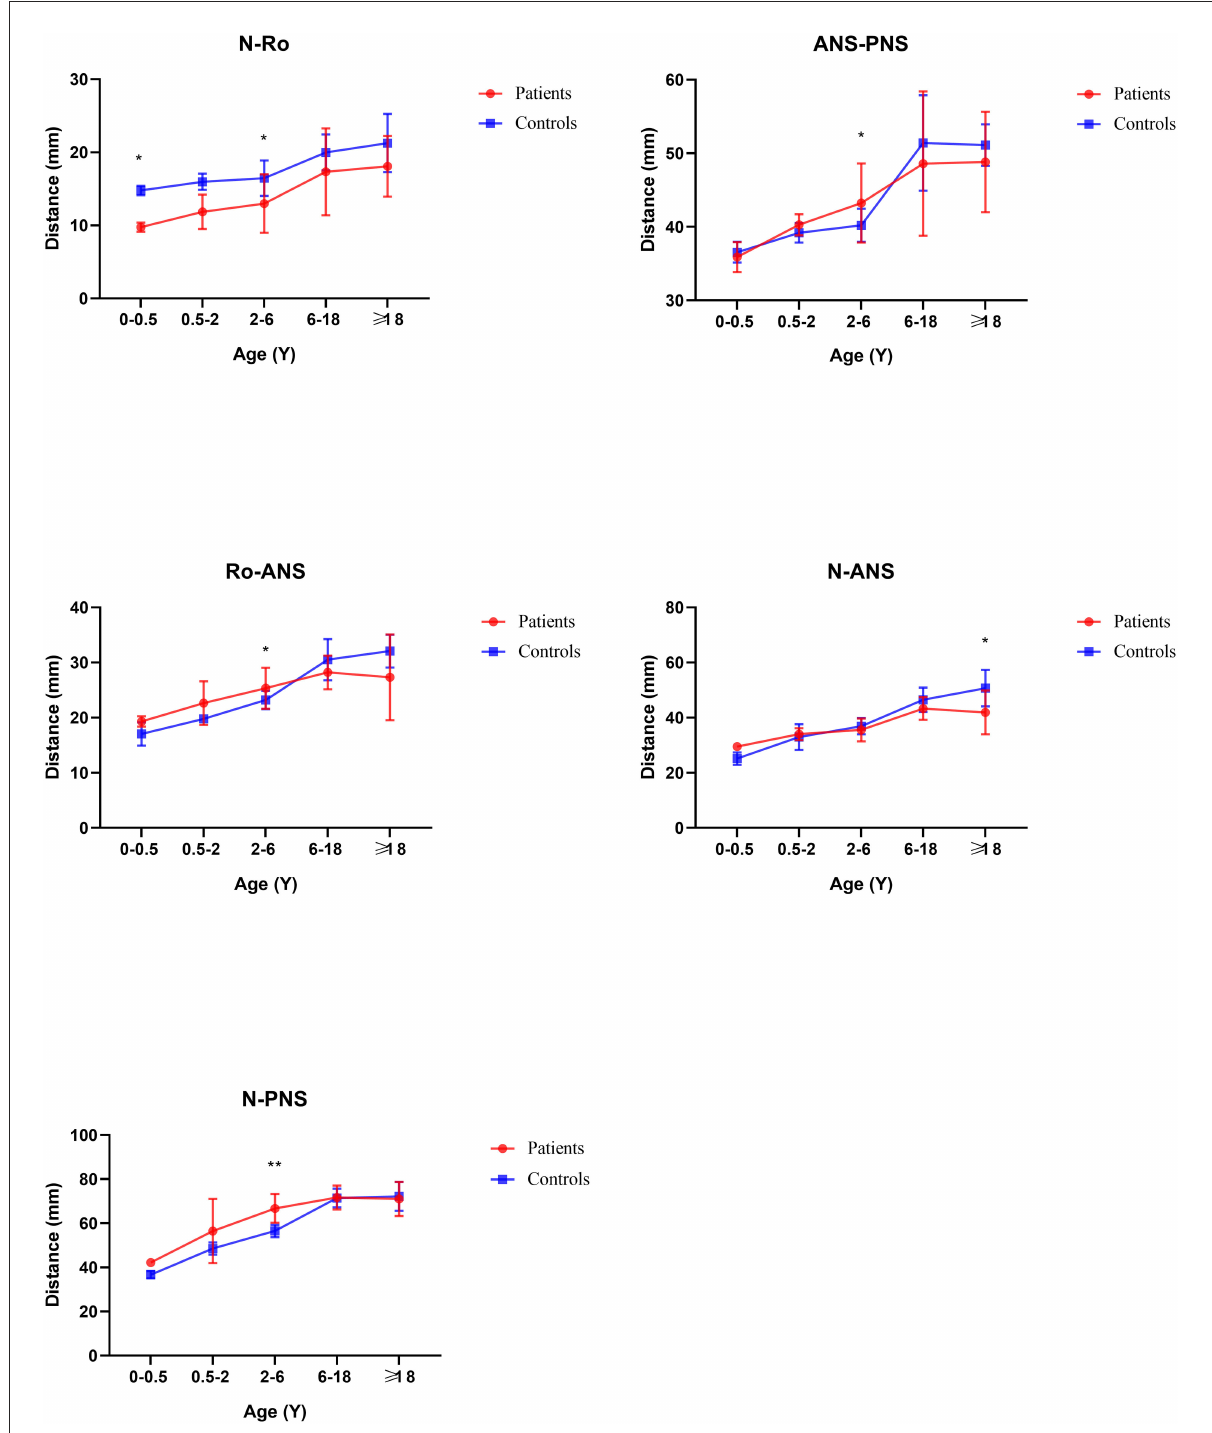
FIGURE4 Sagittal view of face linear measurements by subgroup analysis. * P < 0.05; ** P <